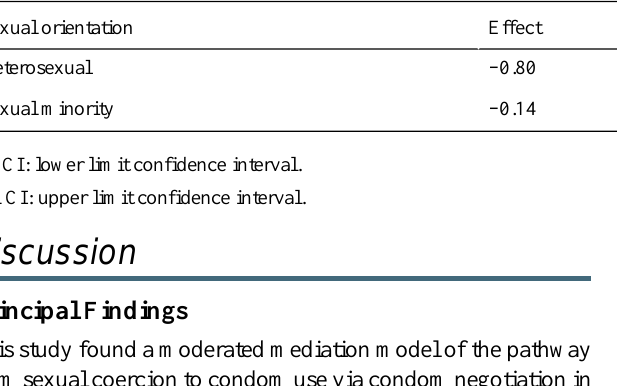
Table 4. Conditional indirect effects of the experience of sexual coercion on condom